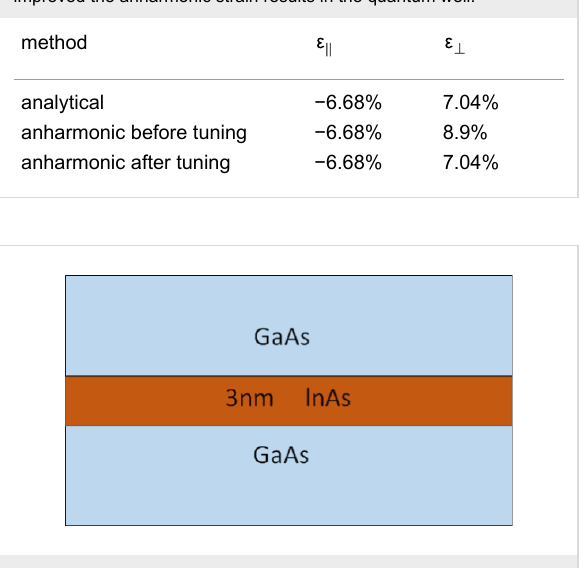
Figure 4: An InAs/GaAs quantum well of thickness 3 nm used for the optimization of the anharmonic strain